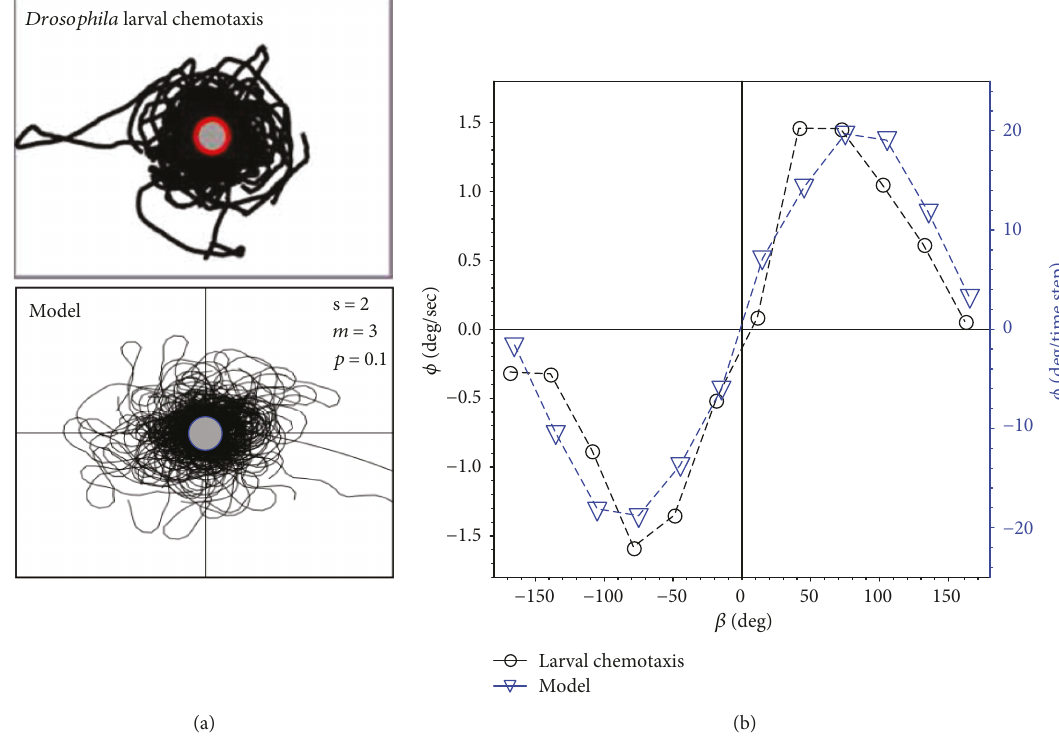
Figure 4: (a) Crawling chemotaxis trajectories from Drosophila larvae taken from [18] (top) and our model (bottom) around a target located at the central colored circle. Both illustrations show the overlap of 47 individual paths. (b) Comparison of the average dependence of ϕ on β between the trajectories from chemotaxis (black circles) and our model (blue inverted triangles). The model parameters are s = 2 , m = 3 , and p = 0 1 . Experimental points are taken from